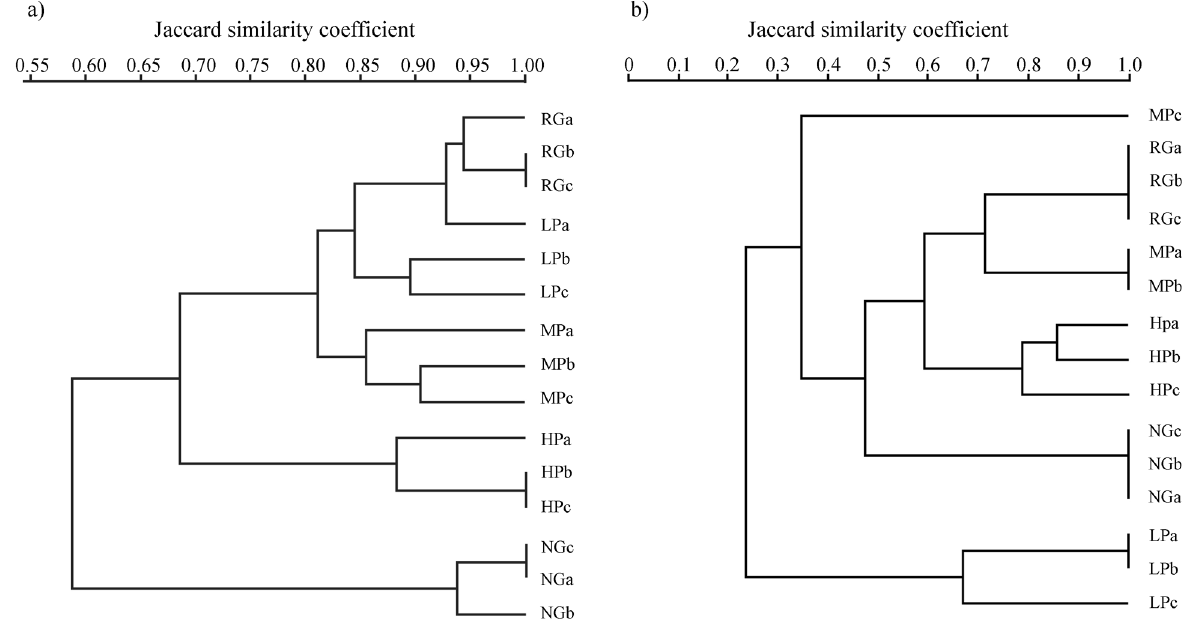
Figure 1 - Dendrograms generated from RFLP profiles of the 16S rDNA (A) and nifH (B) genes from DNA isolated from soil under different grazing in- tensities. HP - high grazing pressure, LP - low grazing pressure, MP - moderate grazing pressure, NG - never-grazed native vegetation, RG - regenerated